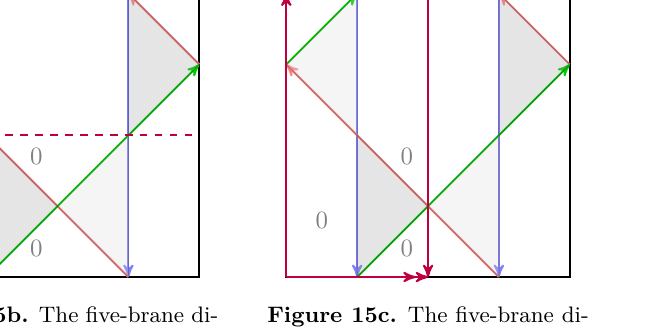
agram of C 2 / Z 2 × C and the horizontal axis that provides the glide orientifold.